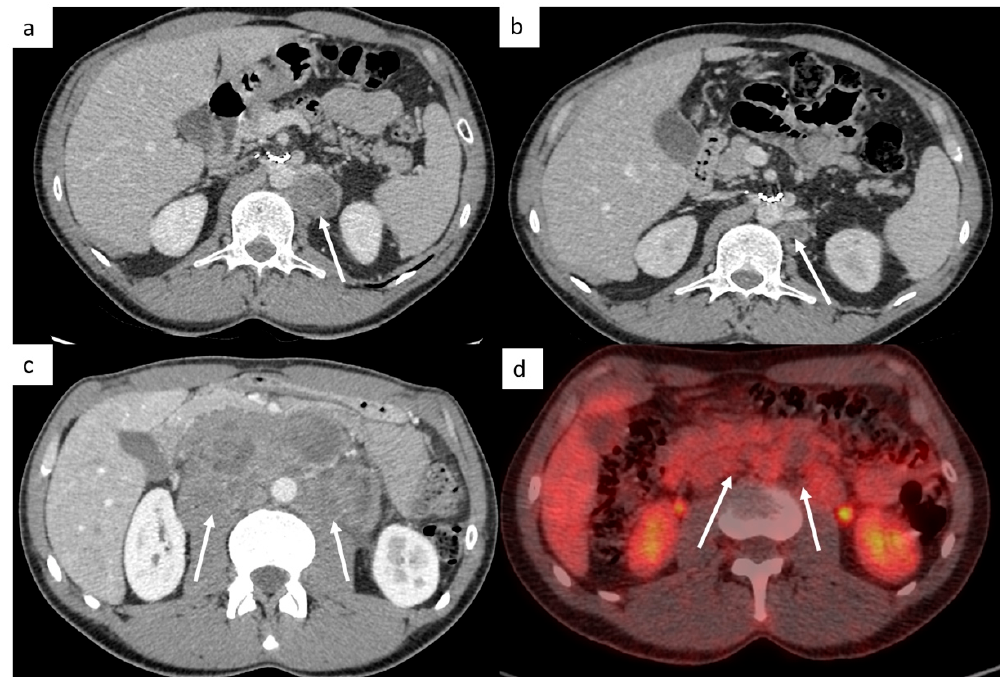
Figure 5. Post-chemotherapy lymph node changes. Abdominal CT reveals a left paraaortic lymph node measuring 27 mm (short axis) at initial staging ( a , arrow). After chemotherapy, CT shows a decrease in the size of this lymph node measuring 14 mm (short axis) ( b , arrow). Lymphadenectomy was performed, and histological examination of the surgical retroperitoneal resection specimen revealed teratomatous tissue and inflammatory changes, without any residual nodal invasion. Imaging in patient with left testicle seminoma ( c , d ). Abdominal CT demonstrates extensive retroperitoneal lymph nodes encasing the aorta at initial staging ( c ); follow-up evaluation after chemotherapy shows significant treatment response: lymph nodes decrease in size (<3 cm) and the FDG-PET CT confirms an excellent response, without increased activity in residual mass ( d ).